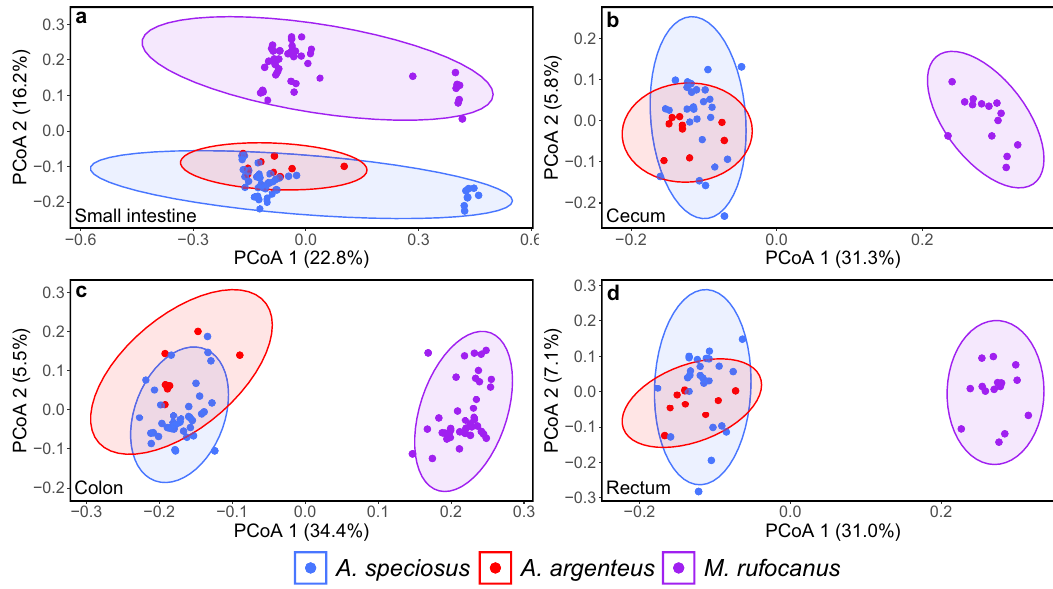
Figure 4. PCoA plots showing among species variation of the gut microbiome within ( a ) the small intestine, ( b ) the cecum, ( c ) the colon, and ( d ) the rectum based on unweighted UniFrac. Ellipses indicate 95% confidence interval and the percentages in parenthesis are the proportion of variation explained by the PCoA